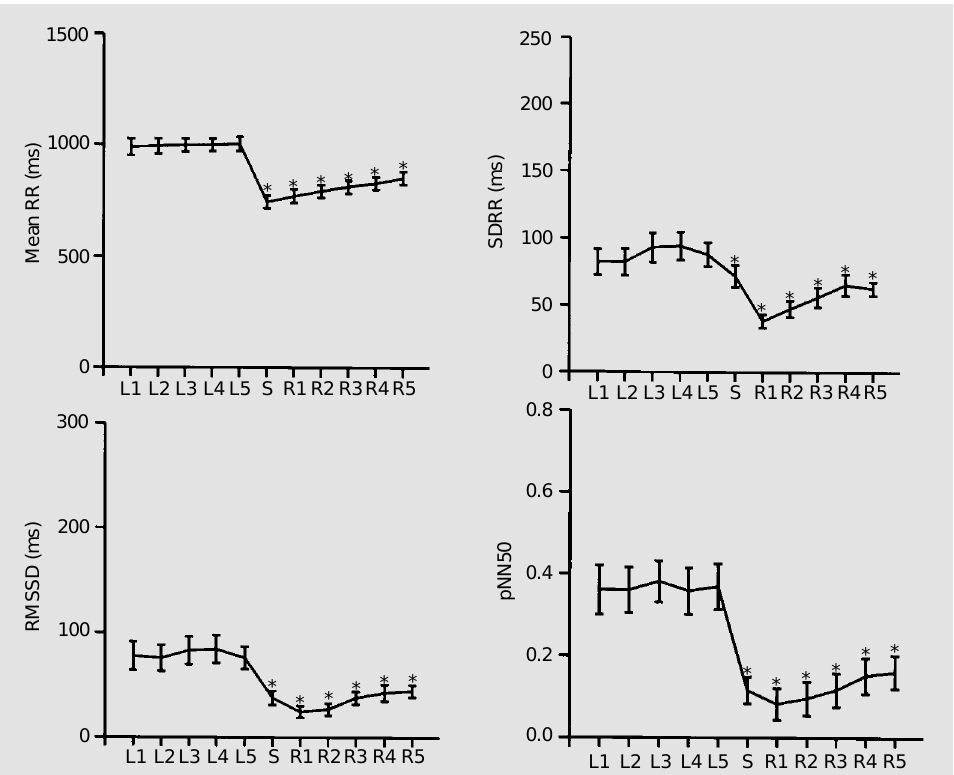
Figure 2. Changes of time do- main heart rate variability indi- ces during the experiment. Data are reported as means and the error bars represent the